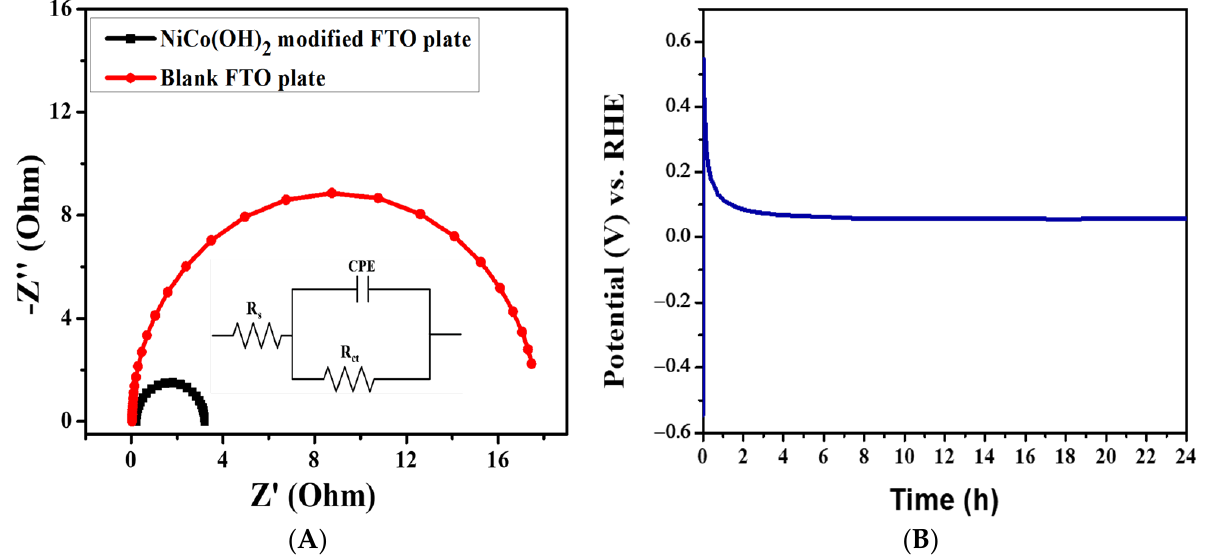
Figure 6. ( A ) Nyquist plot using EIS data obtained for NiCo(OH) Stability of NiCo(OH) 2 /FTO. ( B ) Stability of NiCo(OH) 2